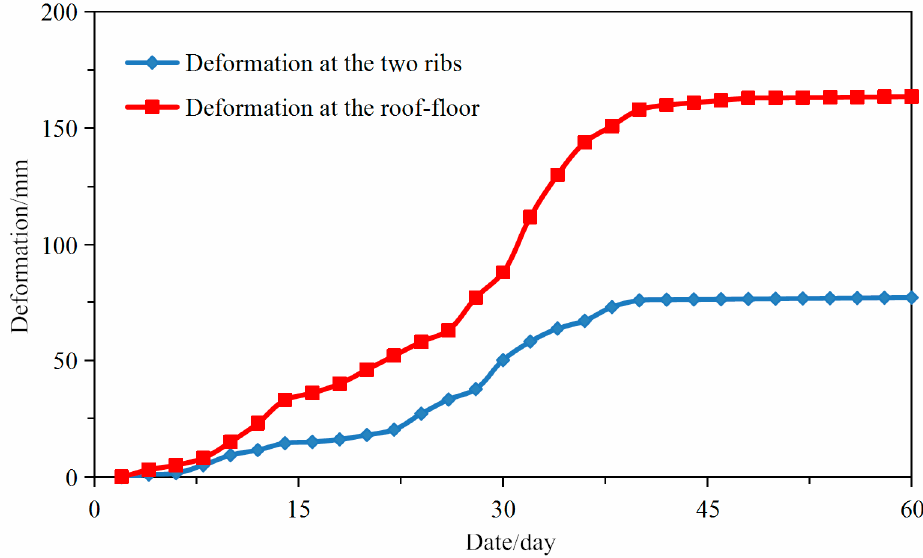
Figure 15. Surface displacement curves.